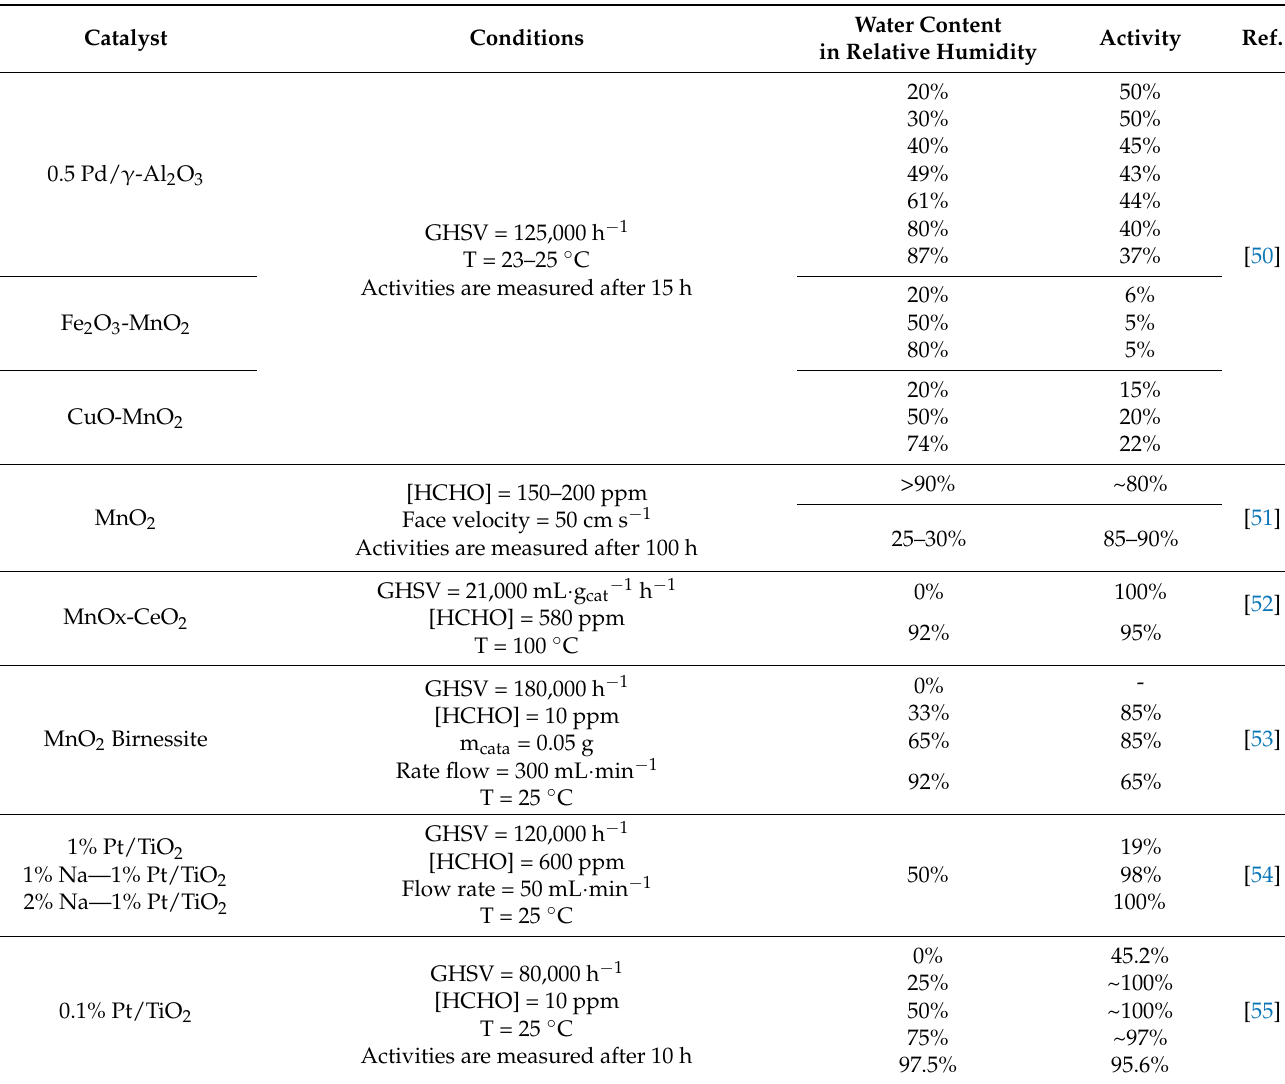
Table 3. Summary of HCHO oxidation catalytic properties in the presence of water reported. Catalyst Conditions